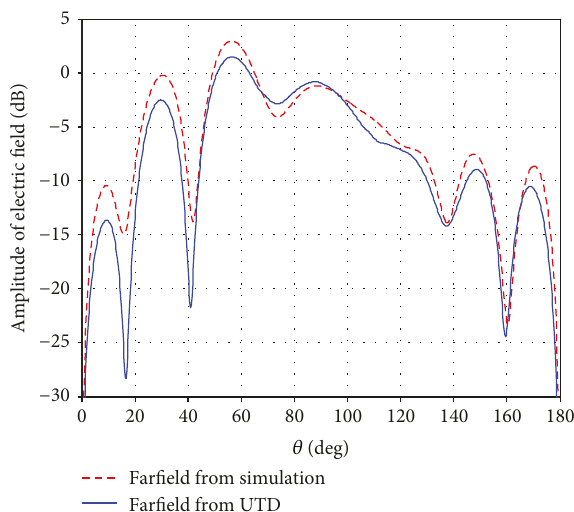
Figure 12: Amplitude of electric fi eld of the θ component in the ϕ =40 ° plane with w =4 λ and h =1 λ , at 4 GHz compared with simulation result.